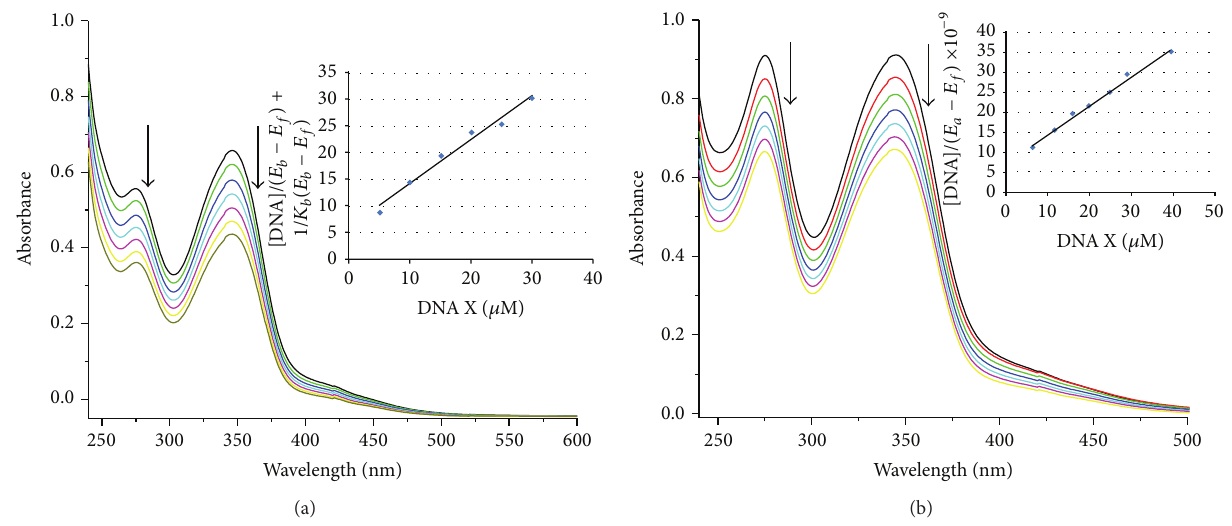
Figure 5: Absorption spectra of (a) Cu(II) and (b) Co(II) complexes in the absence and in the presence of the CT-DNA. [complex] = 30 𝜇 M, [DNA] = 0 to 30 𝜇 M. The arrow indicates absorption intensity decrease with increasing addition of the CT-DNA. Plots of [DNA]/( @ versus [DNA] for the complexes with CT-DNA.